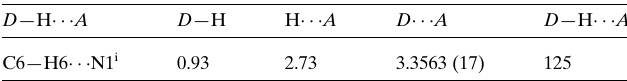
Table 1 Hydrogen-bond geometry (A˚ , (cid:6)